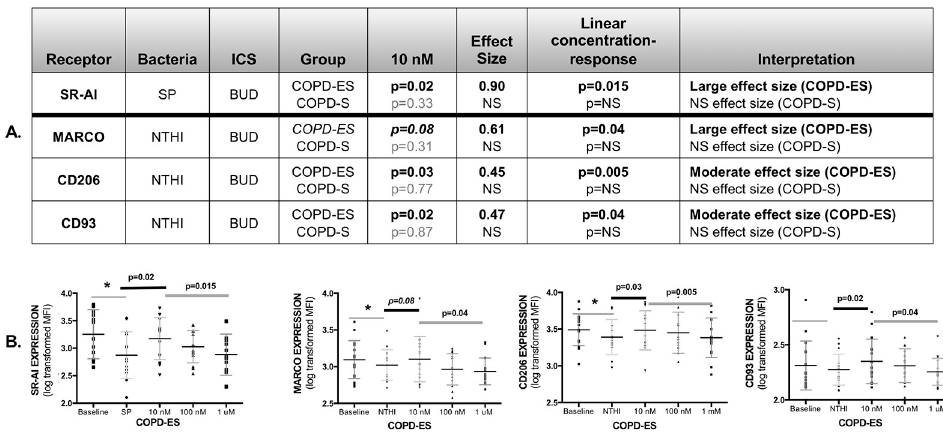
Fig 3. Budesonide increased bacterial recognition receptor expression on MDMs from COPD ex-smokers for both NTHI and SP with greatest receptor upregulation at 10 nM, reflecting an inverse concentration-response relationship. Analysis of log-transformed data on receptor MFI (mean fluorescence intensity). The p-values were calculated by paired T-test, for effect of budesonide (BUD) at 10 nM on SP- or NTHI mediated reduction of receptor expression on MDMs from COPD ex-smokers (COPD-ES) and COPD current smokers (COPD-S). Effect size for BUD effect on MDM receptor expression at 10 nM was calculated by Cohen’s-d calculation. Italicized p-value approached statistical significance, and is reported due to the large effect size. Light grey p-values indicate a statistically not- significant result (NS), and subsequent effect size and concentration-response values are shown as NS (A, Table). Receptor expression is presented as an aligned dot-plot with thin black bar at the mean, flanking short grey bars delineating the SD (B, Figures) . Significant p-values for the BUD effect on receptor expression at 10 nM are noted above the thick, short black bar. Linear trend analysis (denoted by thick dark grey line) was done for concentration- response relationship between 10 nM, 100 nM and 1 μ M of BUD calculated by repeated measures one-way ANOVA. Significant reductions in baseline receptor expression by NTHI or SP are noted by an asterisk ( � ), representing significant data presented in manuscript Fig 2, and S3 Fig. BUD increased expression of CD93 in NTHI-exposed MDMs although CD93 expression was not reduced by NTHI. NS = not statistically